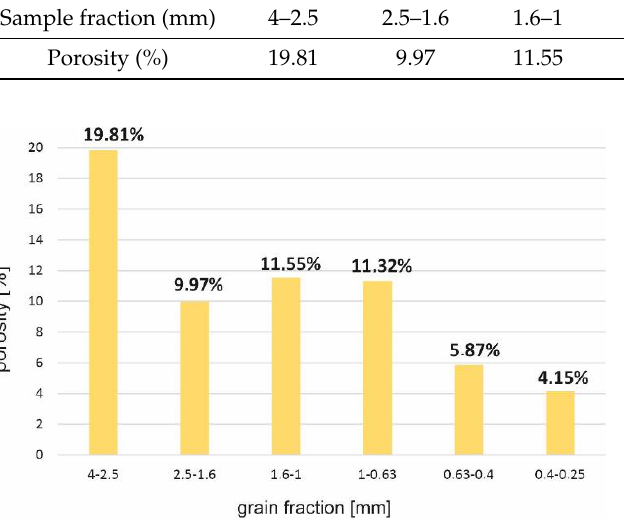
Figure 29. Closed pores visible under a petrographic microscope, polished section, 1P, 100×, re- flected light. Figure 30. Porosity dependence on the analyzed grain fraction (SP2 sample). Table 2. Porosity of individual grain fractions (SP2 sample).